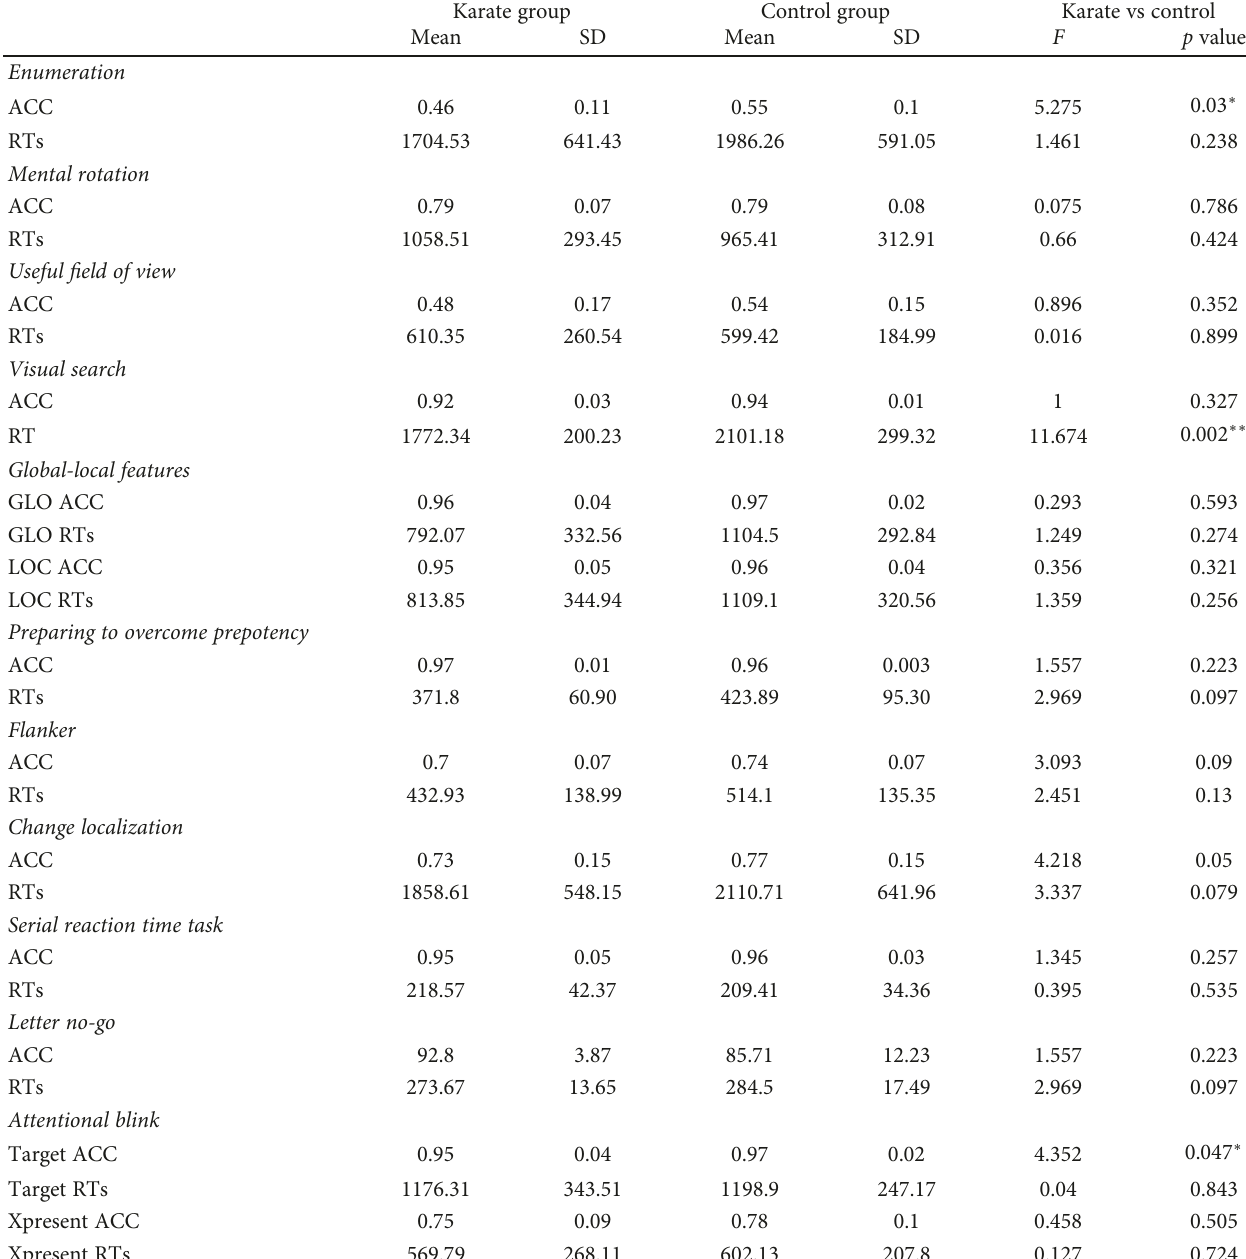
Table 1: Performance of athletes and control group subjects for the cognitive